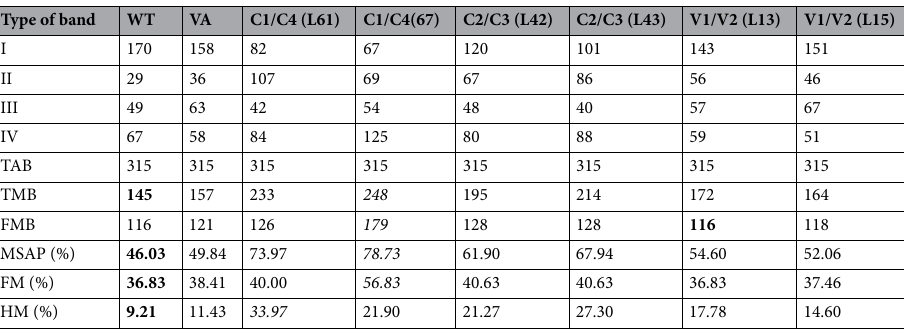
Table 2. The methylation patterns observed in amiRNA transgenics after virus infection. VA and WT were used as controls. The highest values indicated by italic and lowest values indicated by bold. Type I: Absence of methylation due to the presence of bands in both Eco RI/ Hpa II and Eco RI/ Msp I digest; Type II: Bands present only in Eco RI/ Msp I digestion but not in the Eco RI / Hpa II digest; Type III: Bands present in Eco RI/ Hpa II digest but not in the Eco RI/ Msp I digest; Type IV: Absence of band in both enzyme combinations. TAB total amplified bands, TMB total methylated bands, FMB fully methylated bands, FM Full methylation, HM hemi-methylation; the values of TAB = [I + II + III + IV], MB = [II + III + IV], FMB = [II + IV], MSAP% = [(MB/ TAB) × 100], FM% = [(FMB/TAB) × 100], HM% = [III/TAB × 100].